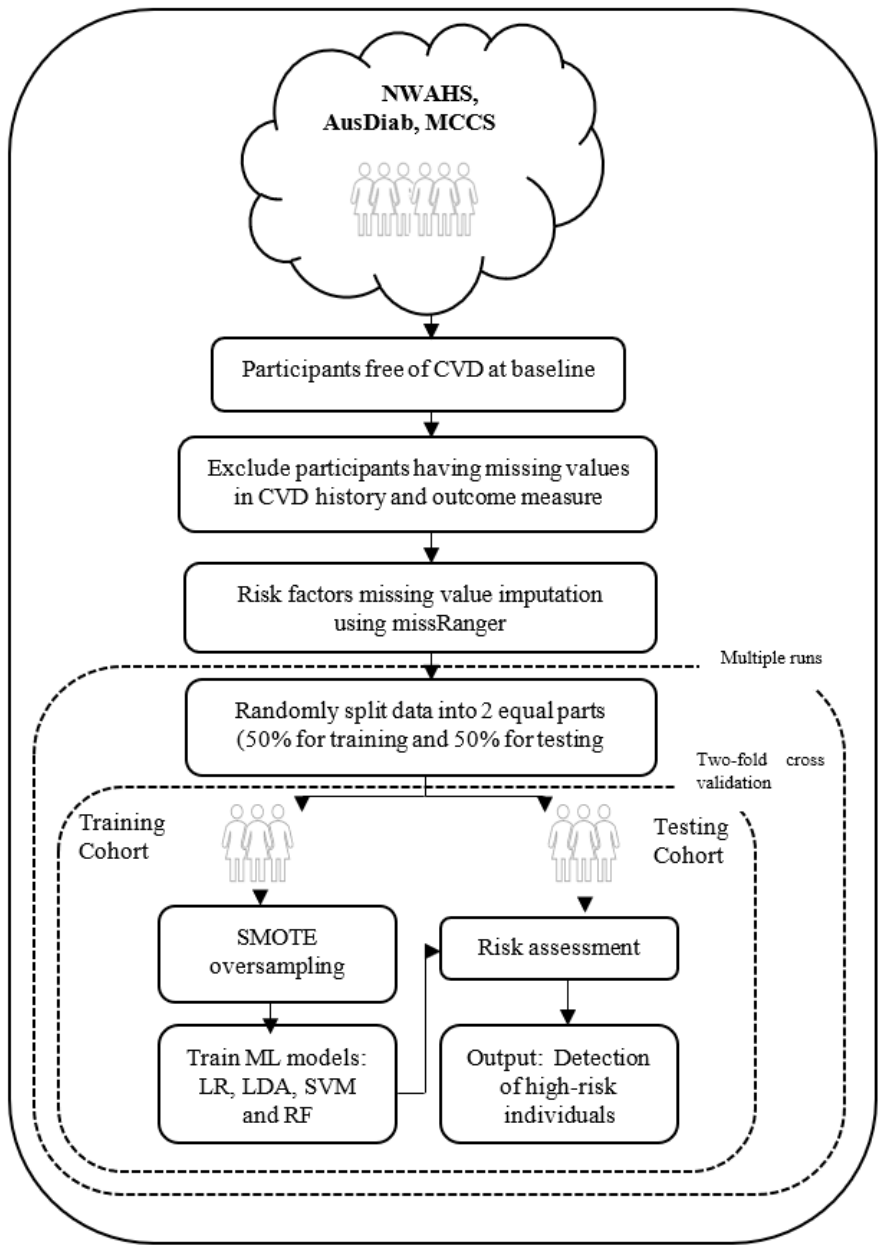
Figure 1. Flowchart describing the machine learning approach. CVD indicates cardiovascular disease; Synthetic Minority Over Sampling Technique (SMOTE); Machine Learning (ML); logistic regression (LR); linear discriminant analysis (LDA); support vector machine with linear kernel (SVM); random forest (RF).